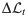
Decoding the cognitive map from neural activity.A. Map-decoding procedure applied to constant-environment reference sessions. The log-ratio ΔLt, Eq (1), which is the difference of likelihoods of map A and B given the recorded neural pattern in theta bin t (Methods), is mostly positive in the reference session with constant light-cue evoking A (blue) and mostly negative in the reference session B (grey). B. Time course of ΔL in a portion of the test session around one light switch (red vertical line). The emergence of flickers (disagreement between the recalled map and the light cue) is clearly visible after the light switch. Yellow horizontal dashed lines show the statistical threshold applied in map decoding and flicker identification (|ΔL|>L0=log10, Methods). Yellow bars represent the identified flicker instabilities, i.e. significative discordances (ΔL<-L0) between the decoded cognitive map (here, B) and the post-switch light conditions (here, A). C. time correlation of flickers, computed with significance threshold L0 = log 10. The exponential fit shows that correlations extend over ∼6 theta bins, highlighting the tendency of the cognitive map to persist beyond the theta cycle.